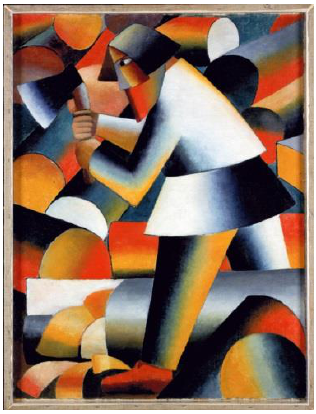
Fig. 25 The Woodcutter (Malevich, 1912)